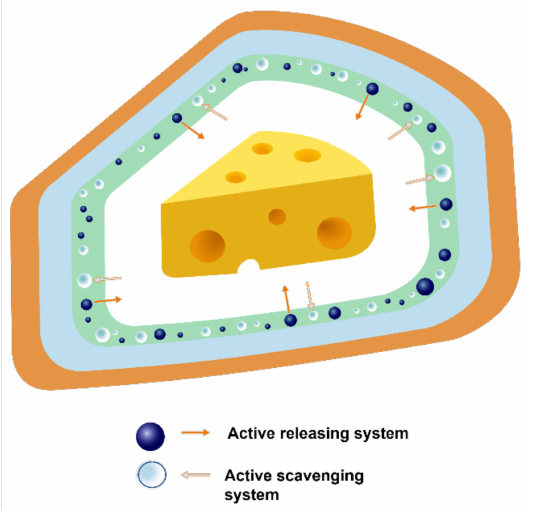
Figure 6. Active packaging system.